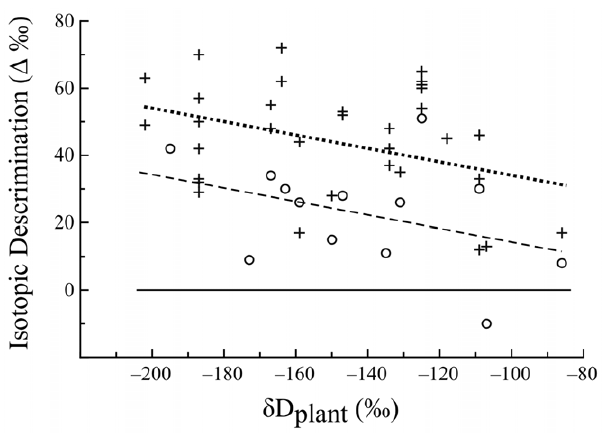
Figure 4. The isotopic discrimination factors between the tissues of caterpillars (plus ‘ + ’ signs, dotted line) and moths (open circles, barred line) decreased significantly with the d D value of plant tissues according to a shallow common slope. Note that the discrimination factors for plants, caterpillars and moths differed significantly from one another (Tukey’s test, p , 0.05). The horizontal reference line represents D D=0.